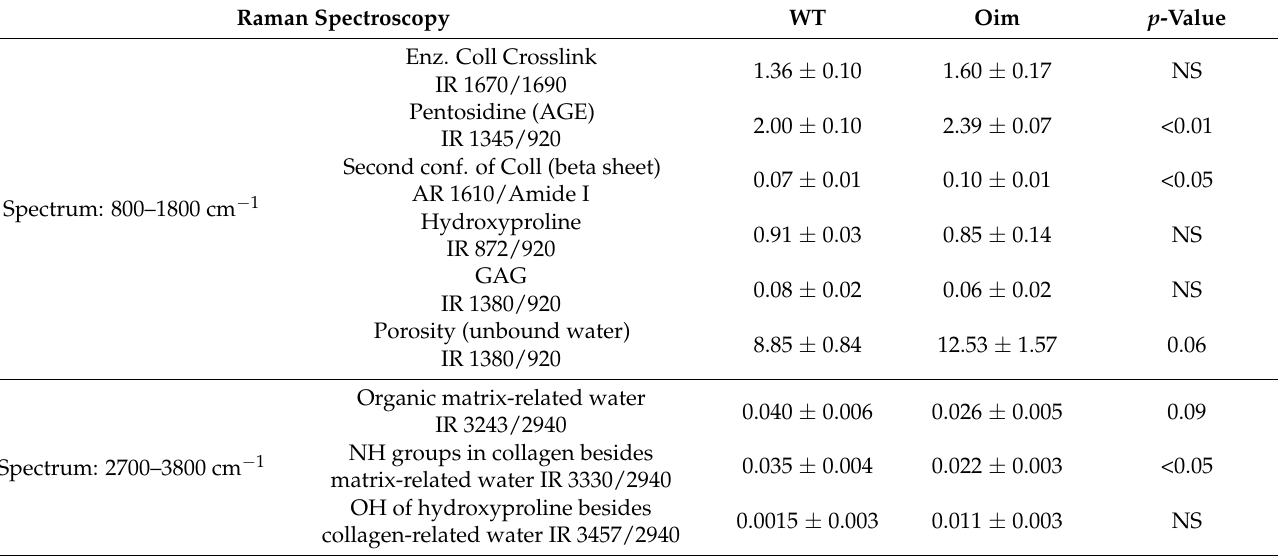
Table 1. Tissue material properties of triceps brachii tendon assessed with Raman